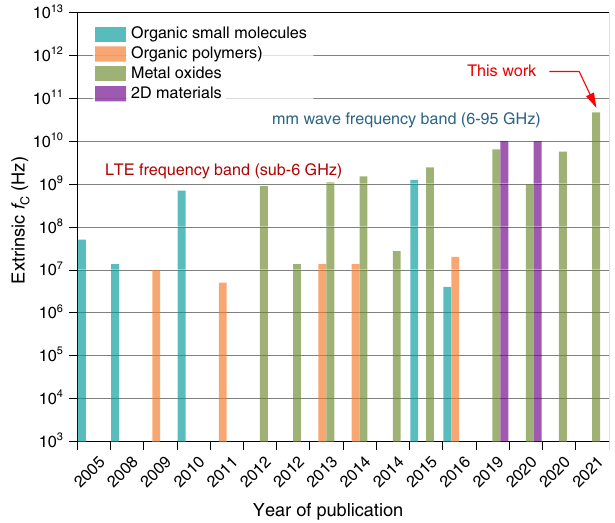
Fig. 5 Comparison of state-of-the-art Schottky diodes based on different semiconductor technologies and processing methods. The plot compares the extrinsic cut-off frequency, (f C ) of our current diodes (This work) with previously reported Schottky diodes fabricated using different semiconductor materials (i.e. organic small molecules, organic polymers, metal oxides and 2D materials), via vacuum and solution processing methods. The literature data used for this fi gure are summarized in Supplementary Table